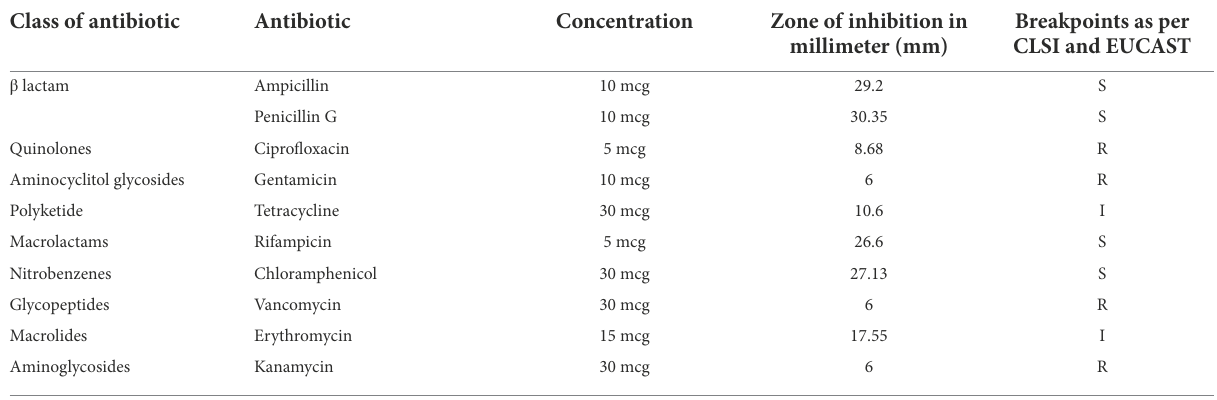
TABLE 5 Antibiotic susceptibility of Lactobacillus plantarum GXL94. Class of